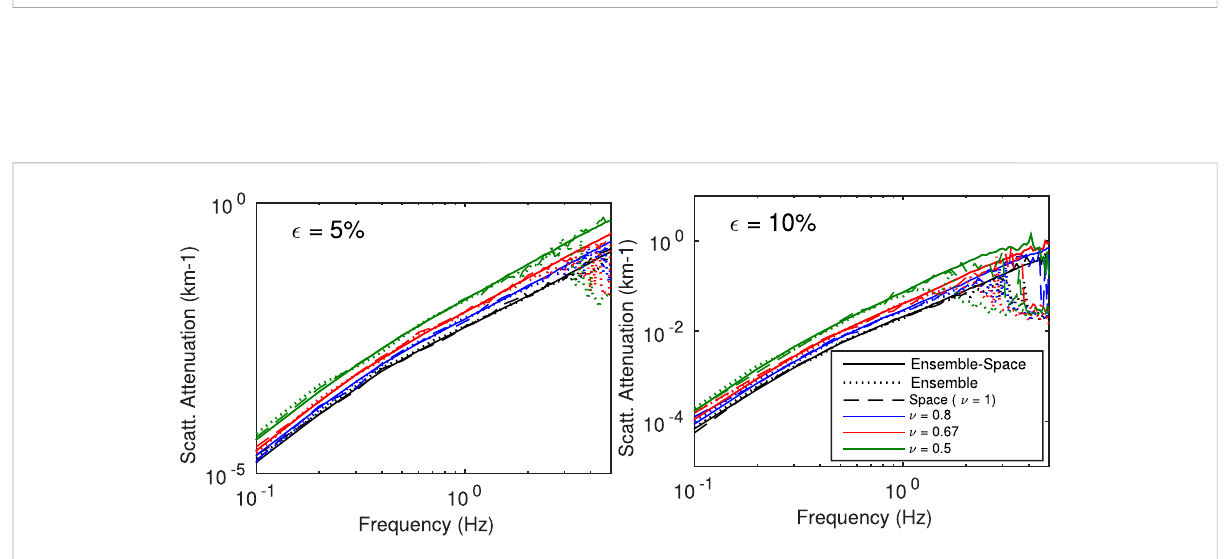
FIGURE 5 Comparison of scattering attenuation estimates obtained with different measures of the coherent wave fi eld: ensemble average (dotted lines), space average (dashed lines) and ensemble-space Average (solid lines). Left (resp. right) fi gure corresponds to random media with ε = 5% (resp. ε =